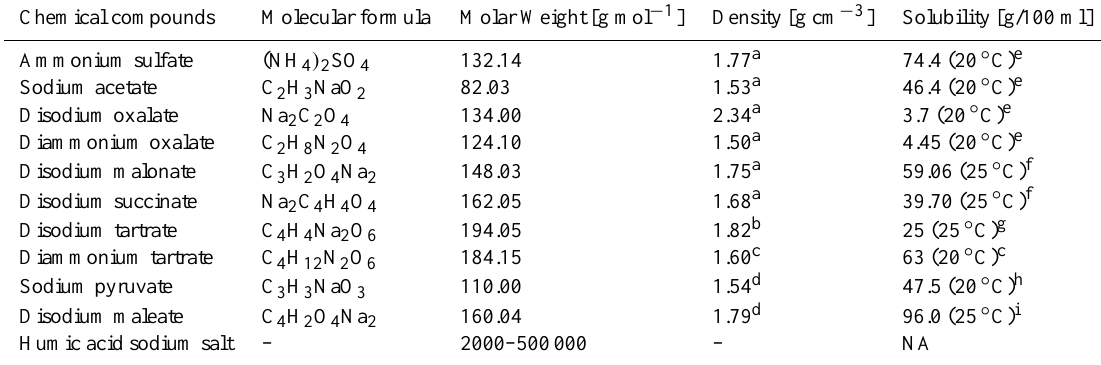
Table 1. Properties of salts being studied. Chemical compounds Molecular